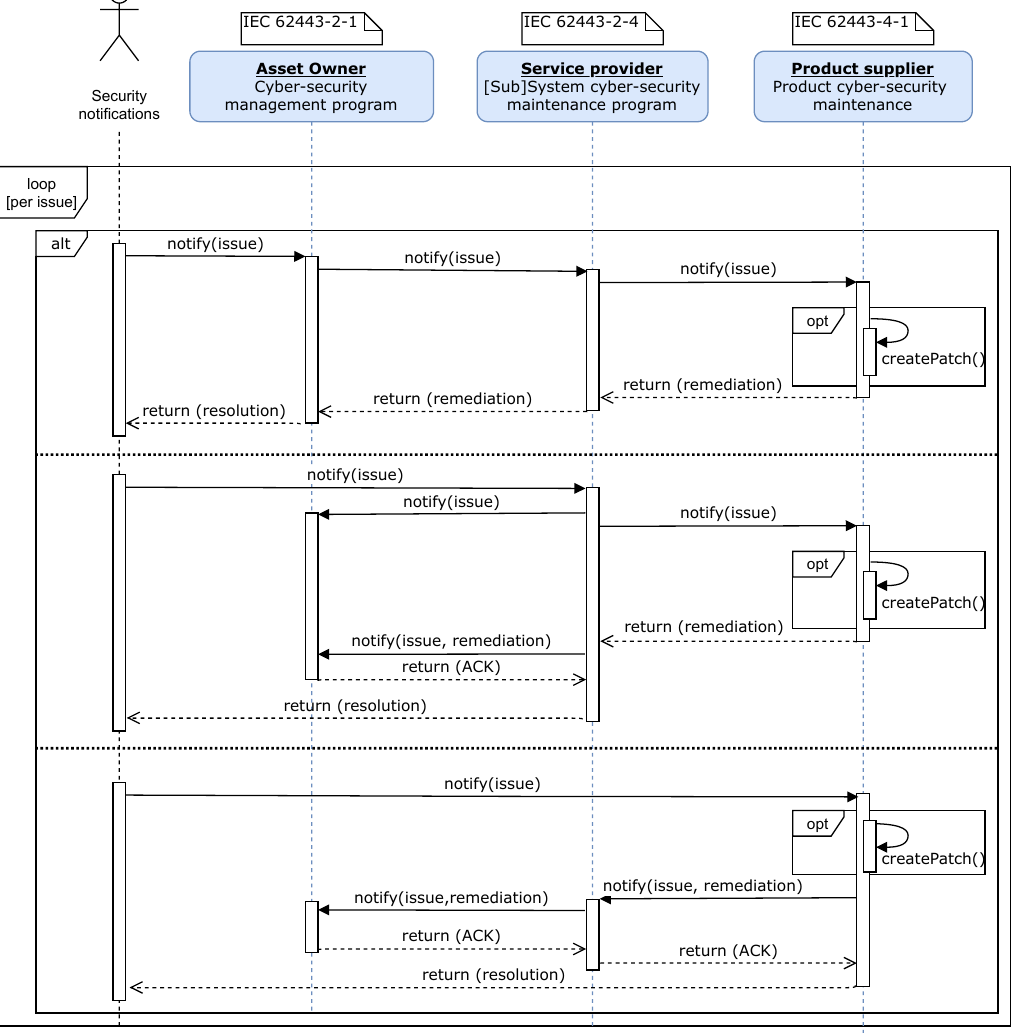
Figure 6. Security-related notifications and treatment sequence